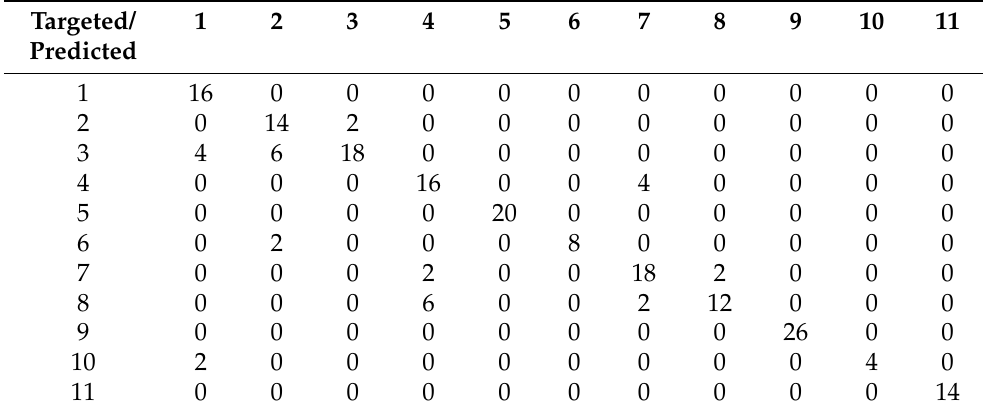
Table 3. The example of the confusion matrix for LoDVP Abnormal